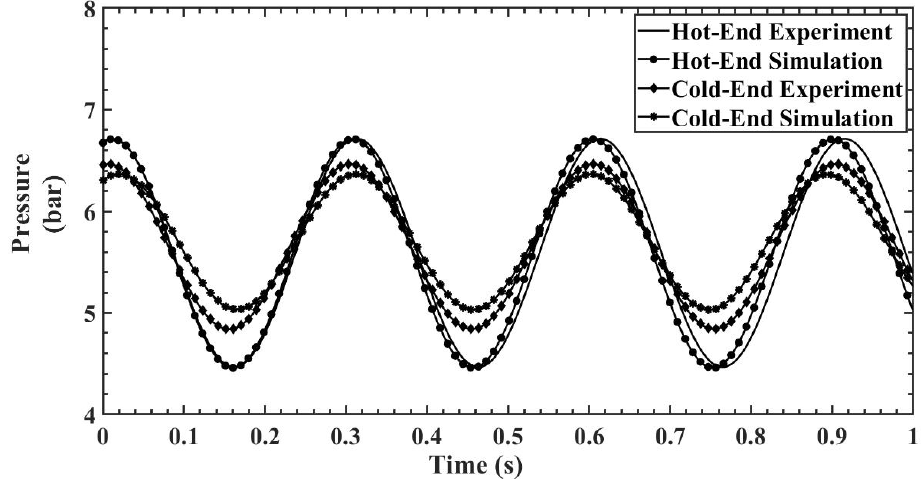
Figure 9. Hot- and cold-section pressure characteristics of a 300 mesh regenerator at 200 RPM.